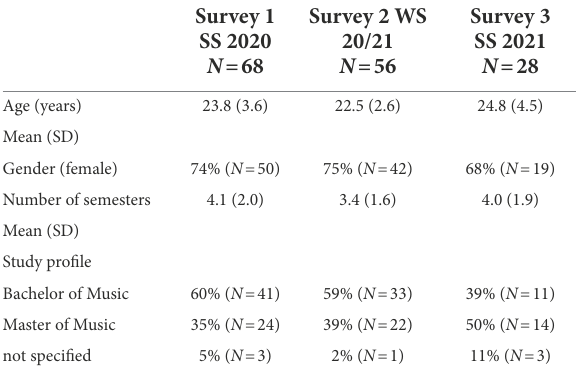
TABLE 1 Characteristics of the student samples in the